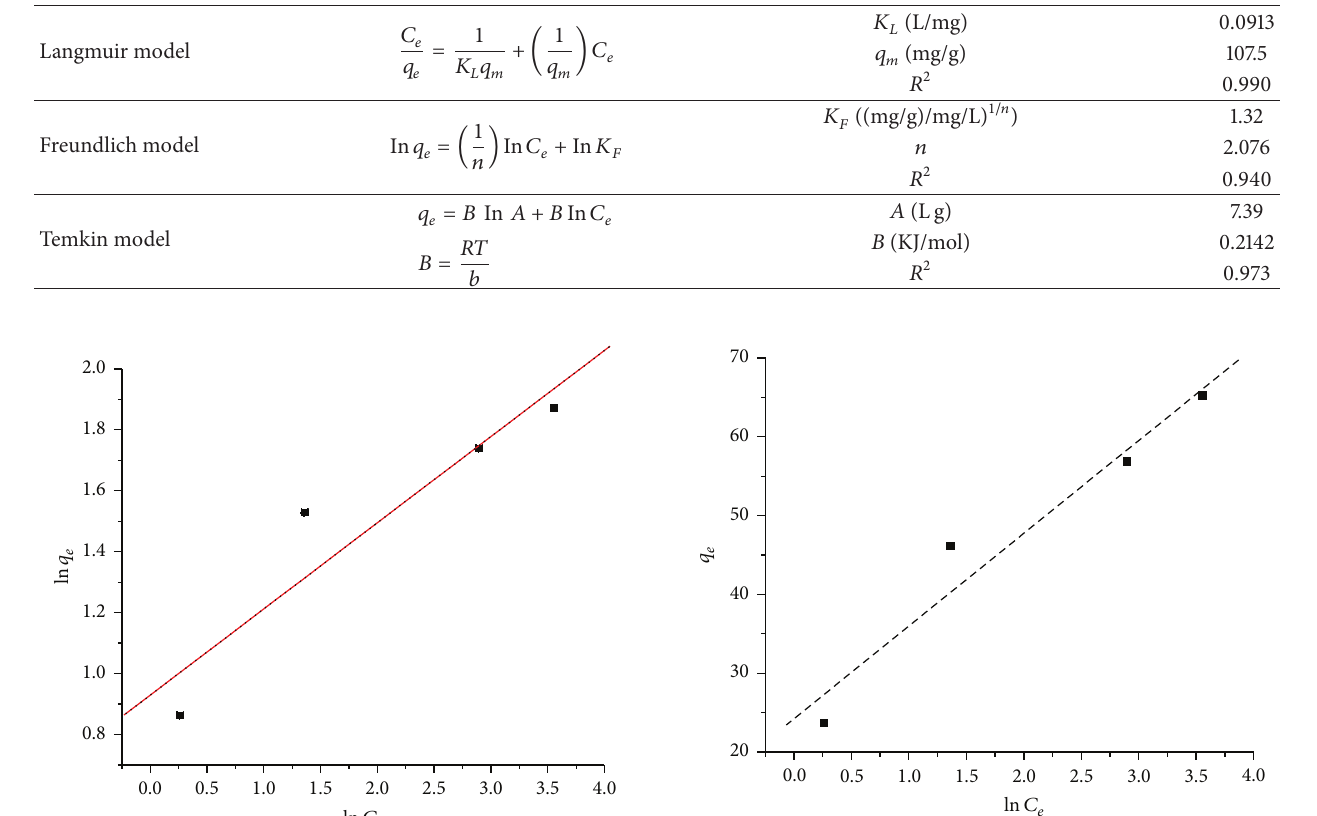
Figure 9: Temkin isotherm model of Hg(II) sorption onto ALP biomass (at 303 K, pH